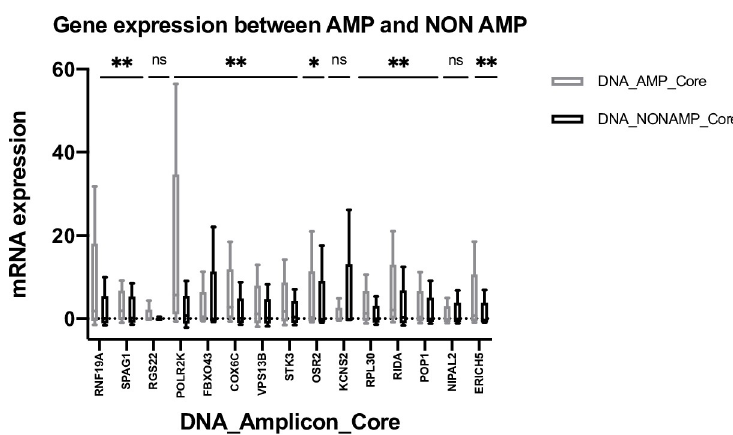
Fig 5. Median mRNA expression of DNA_Amplicon_Core between AMP and NONAMP